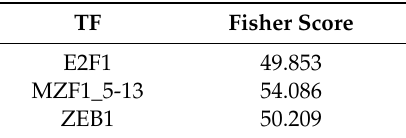
Table 1. Transcription factors (TFs) whose binding sites were enriched in the DEGs, and their associated Fisher score. oPOSSUM software was used to identify TFs with a Fisher score greater than 2 standard deviations above the mean.